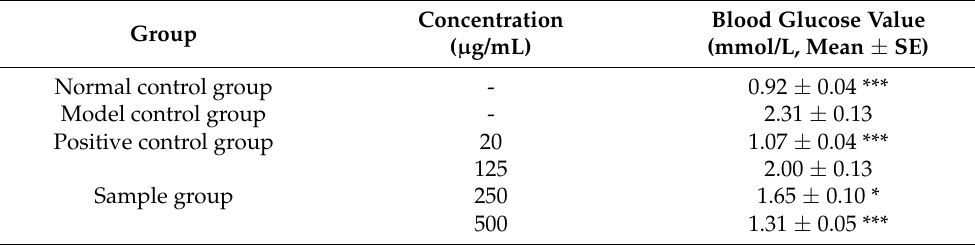
Table 4. Experimental result of FEAK-assisted hypoglycemic effect ( n = 10).